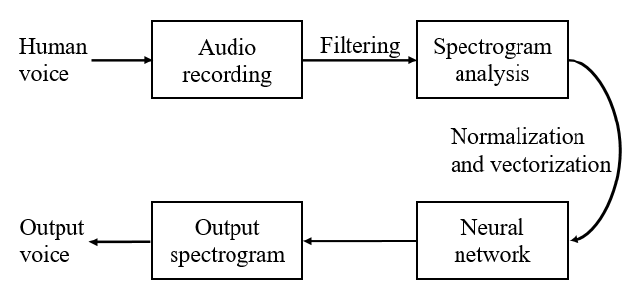
Figure 5. Flow map of the experiment.